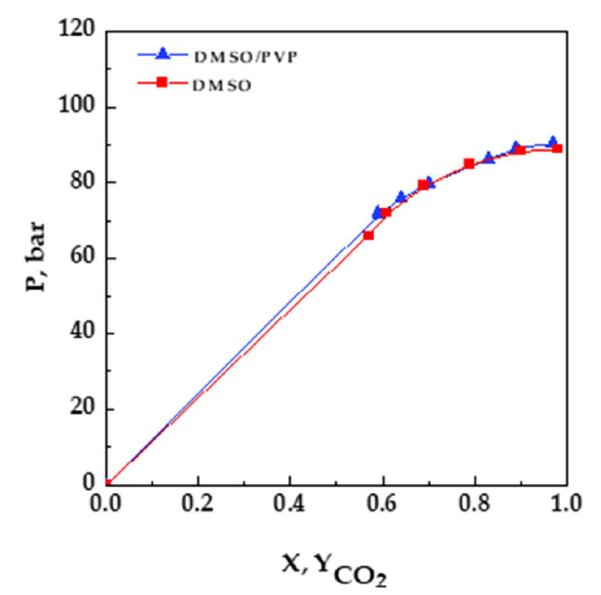
Figure 2. Comparison P-x diagram between DMSO/CO 2 system and DMSO/CO 2 /PVP mixture at a temperature of 313 K. Table 1. Experimental data for DMSO/CO 2 /MEN system at 313 K.